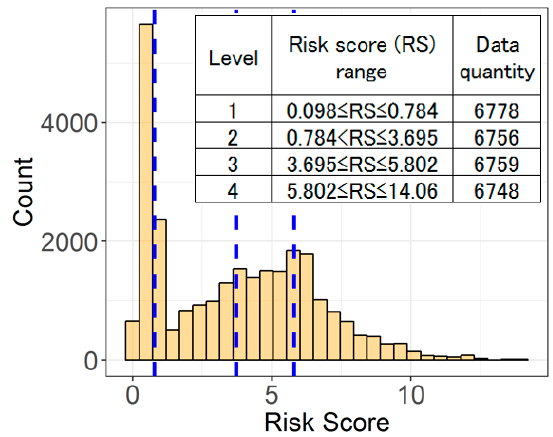
Figure 16. Risk score distribution in the Tokyo region.